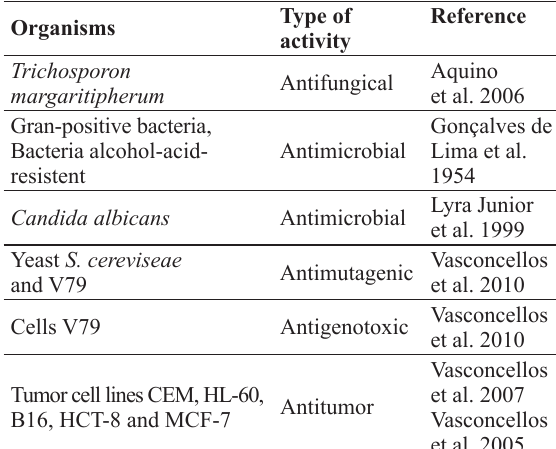
Biological activities of biflorin shown in different